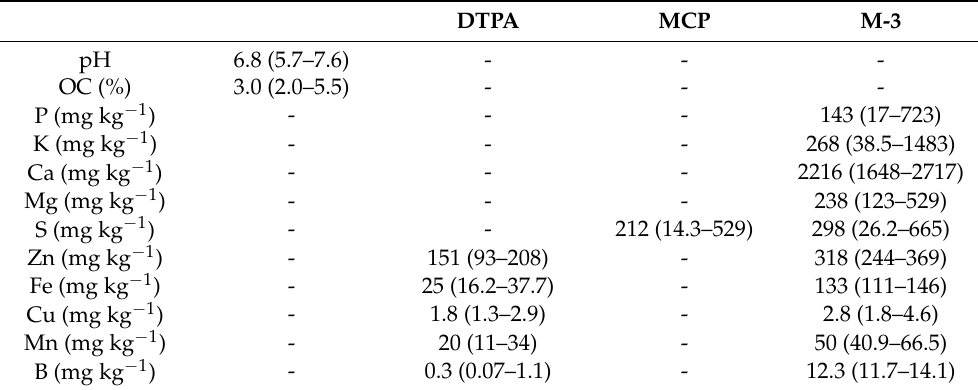
Table 2. Mean pH, organic carbon (OC), and nutrient contents of the soils treated (and untreated) with